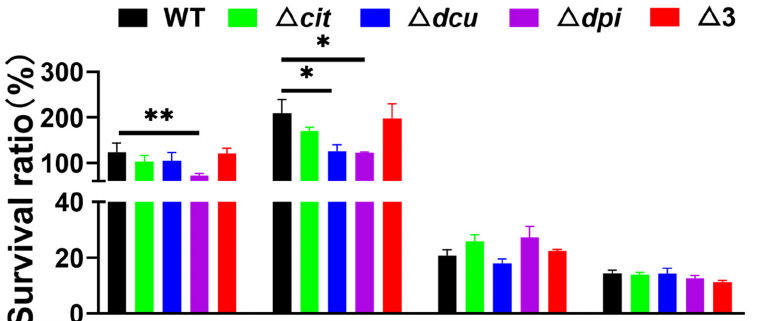
Figure 3. Hyperosmotic, oxidative, acid and heat stress assays. Treatment conditions from left to right were 10% glucose solution for 30 min, 4 mM hydrogen peroxide solution for 30 min, NaCl solution with pH 3.5 for 30 min and 50 °C for 10 min, respectively. Statistical significance of differences was evaluated by one-way ANOVA test (* p < 0.05; ** p < 0.01).